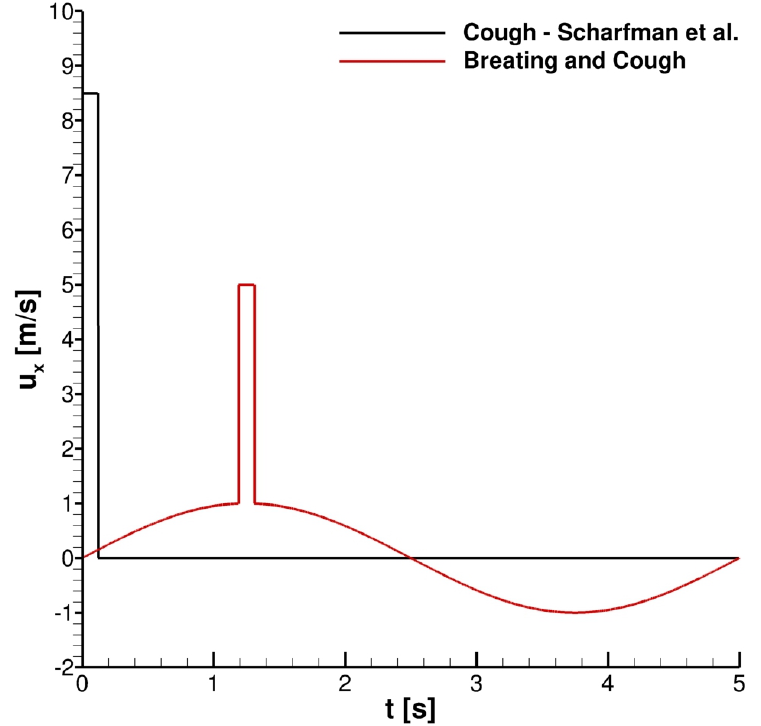
Figure 2. Velocity time histories at mouth print